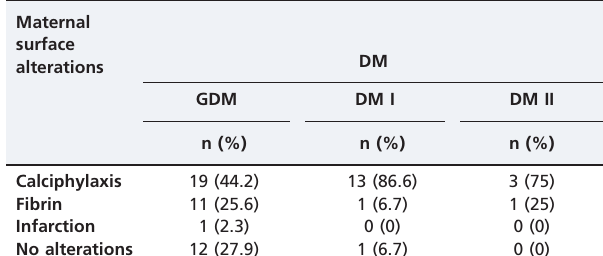
Table 1 - Distribution of placental macroscopic